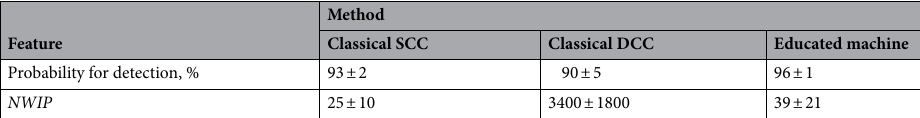
Method Feature Classical SCC Classical DCC Educated machine Probability for detection, % 93 ± 2 90 ± 5 96 ± 1 NWIP 25 ± 10 3400 ± Table 2. A comparison between the classical and educated machine. Performances are averaged for all materials; the educated machine was operated at optimal parameters.